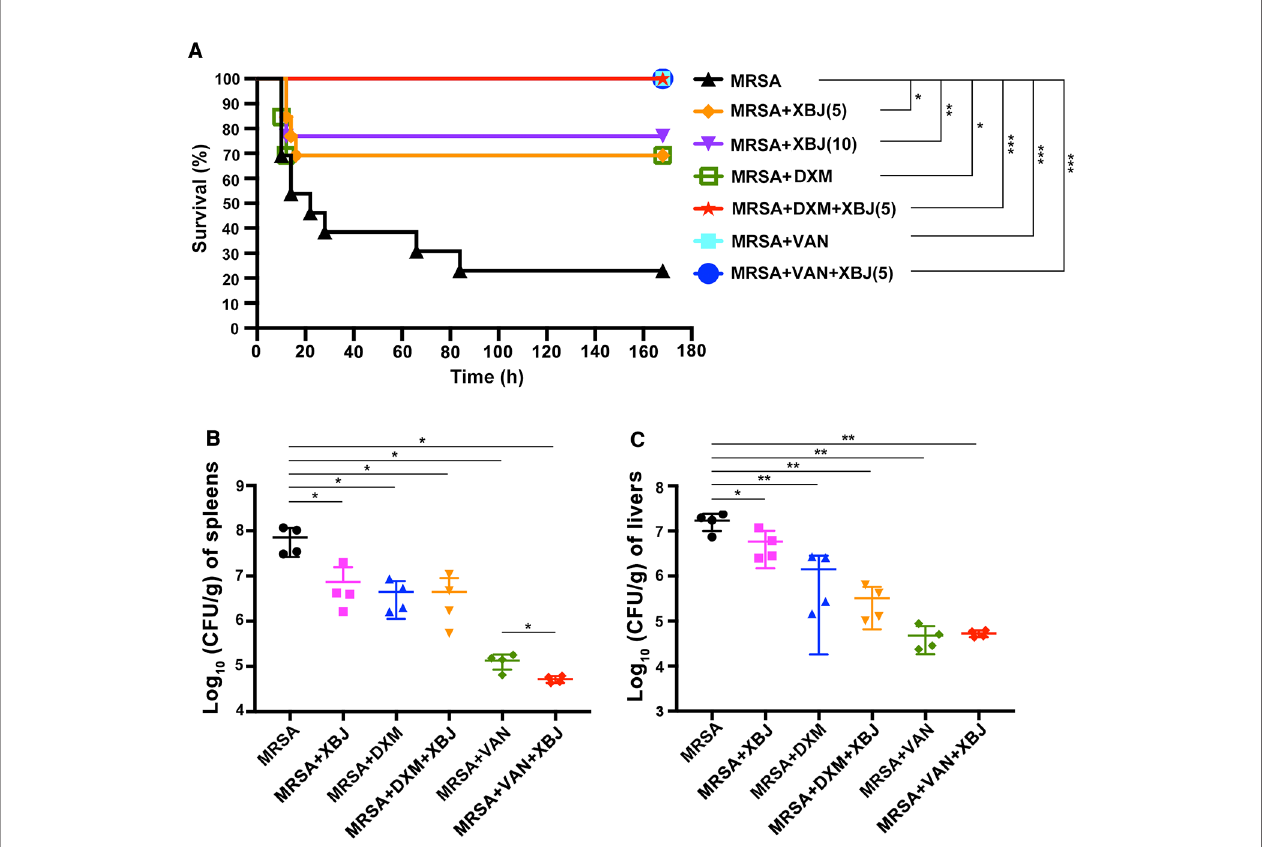
FIGURE 2 | XBJ protected mice from lethal infection with MRSA and decreased the bacterial load in spleens and livers in MRSA-challenged mice. (A) C57BL/6J male mice were randomly divided into 7 groups (N=10 – 13/group). All groups of mice were intraperitoneally injected by lethal dose of MRSA (7 × 10 8 CFU/mouse) and corresponding agents, respectively. The survival data were recorded in the following 7 days. (B, C) C57BL/6J female mice were randomly divided into six groups (N=4/group). All groups of mice were intraperitoneally injected with MRSA (2 × 10 8 CFU/mouse) and XBJ (5 ml/kg), DXM (7 mg/kg), VAN (110 mg/kg), and their combination in corresponding groups. After 12 hours, mice were sacri fi ced and organ samples were harvested, weighed, homogenized, and coated on agar plates. After incubation at 37°C for 18 hours, CFU were calculated and the bacterial load was expressed as log 10 (CFU/g) per organ. Data were analyzed using log- rank test (A) and unpaired t -test (B, C) with GraphPad Prism 8.0. * , ** , ***Signi fi cantly different at p < 0.05, p < 0.01, and p < 0.001,